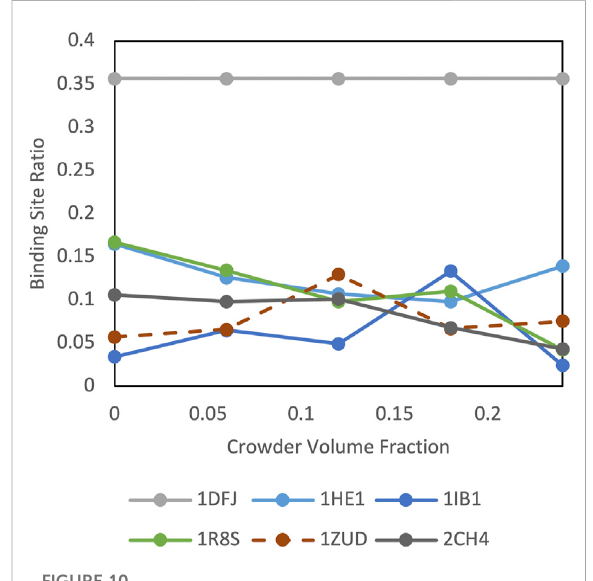
FIGURE 10 Crowding effect on special cases of cytosolic complexes.